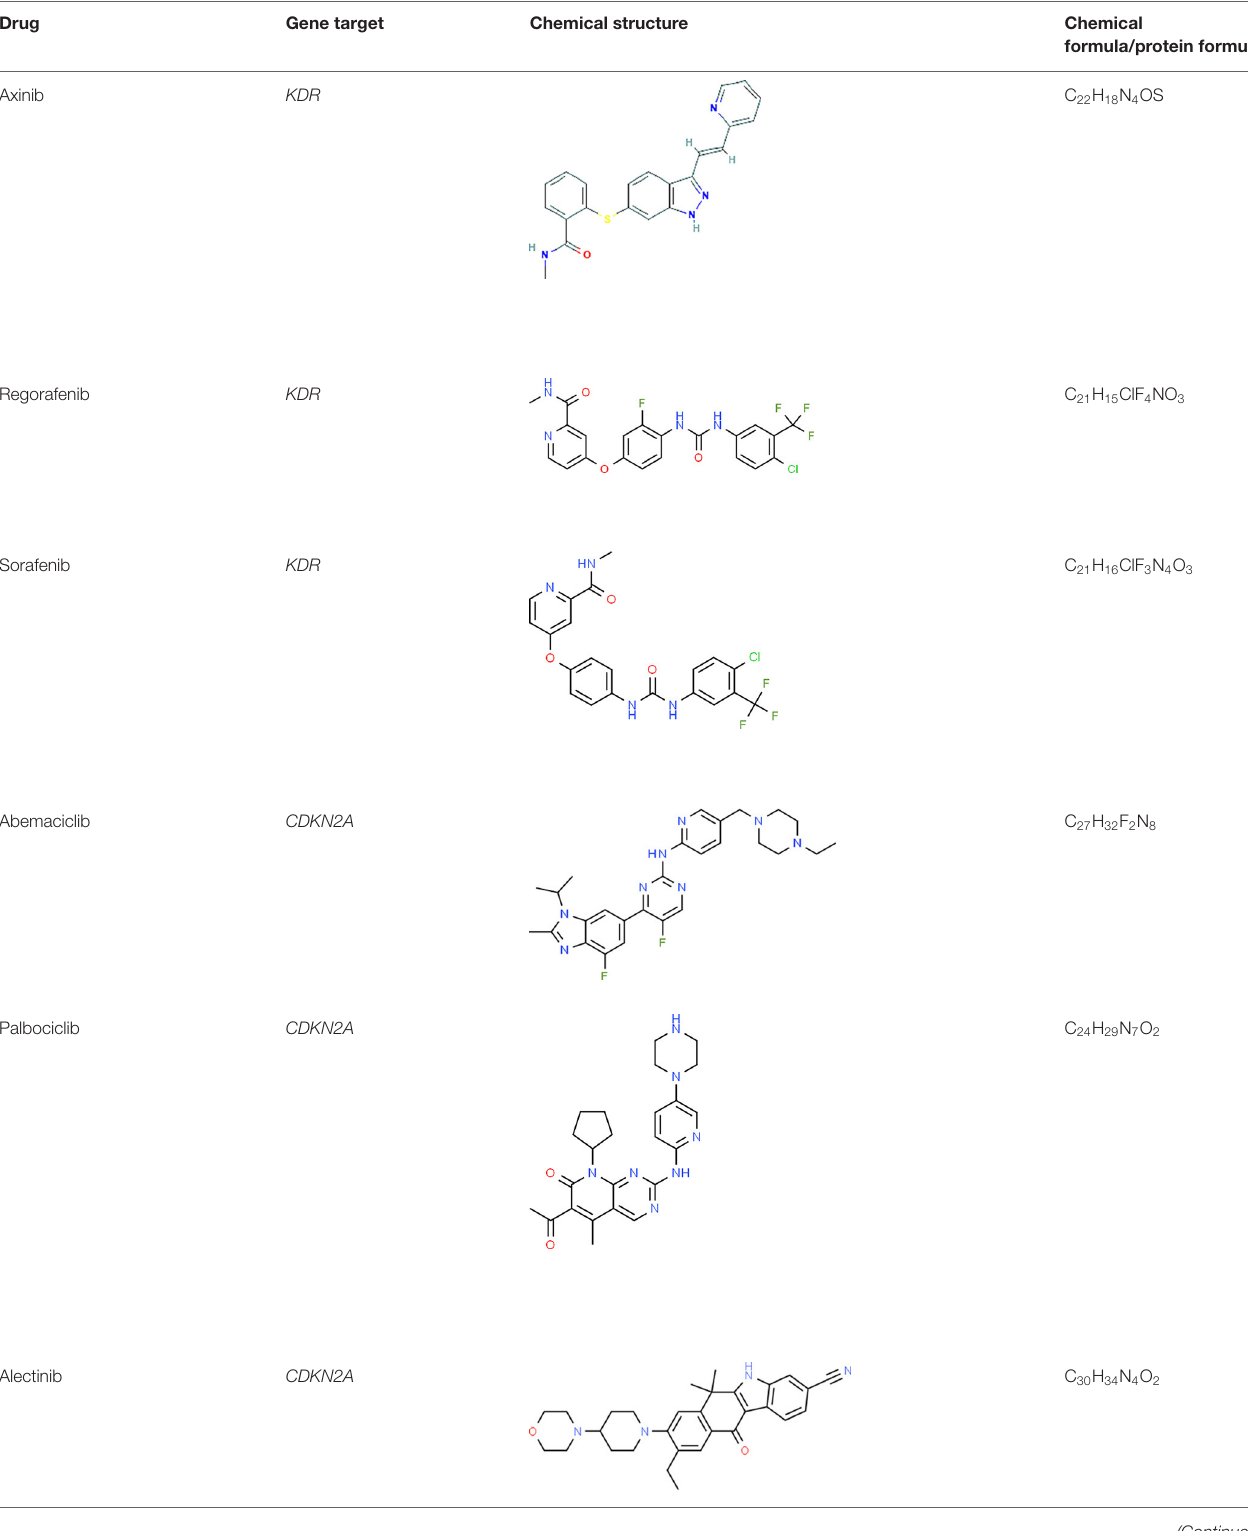
Drug Gene target Chemical